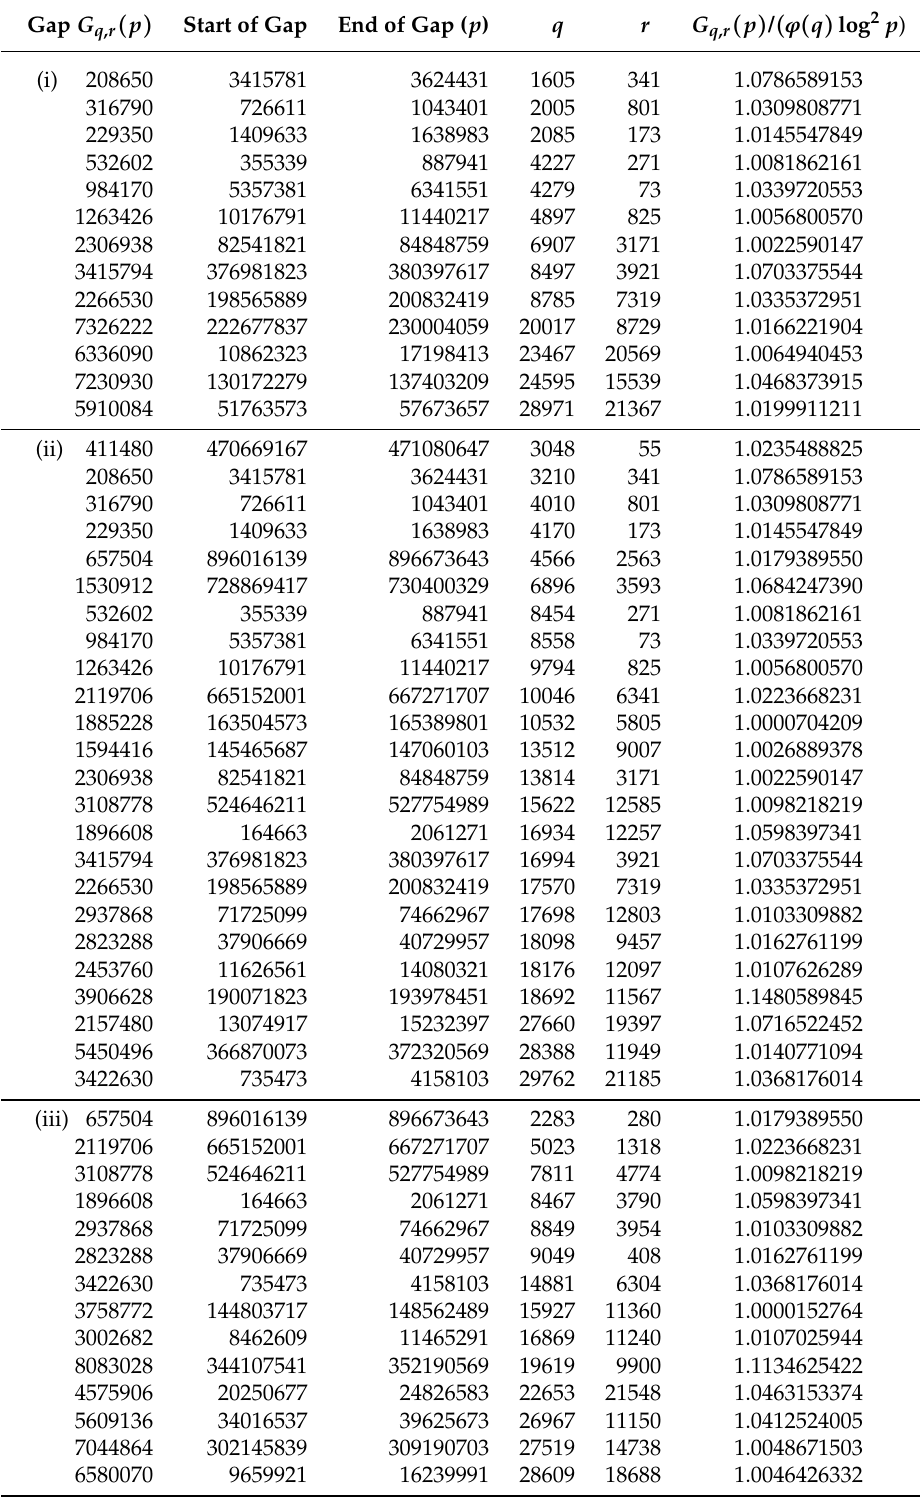
Table 1. Exceptionally large maximal gaps: G q , r ( p ) > ϕ ( q ) log 2 p for p < 10 9 , r < q ≤